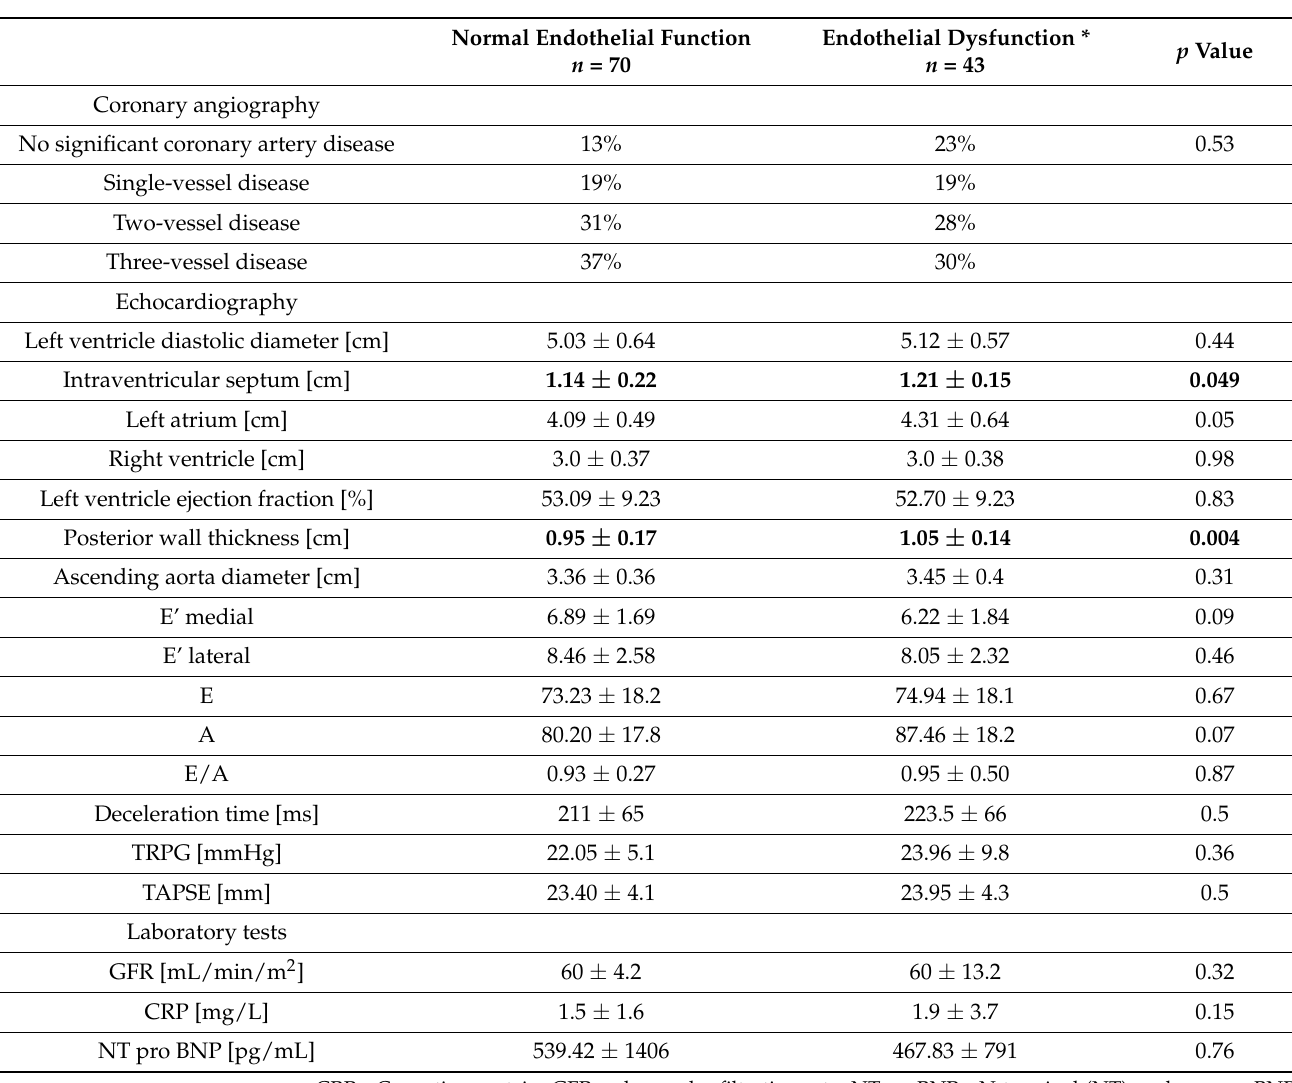
Table 2. Coronary artery disease, echocardiography data and basic laboratory